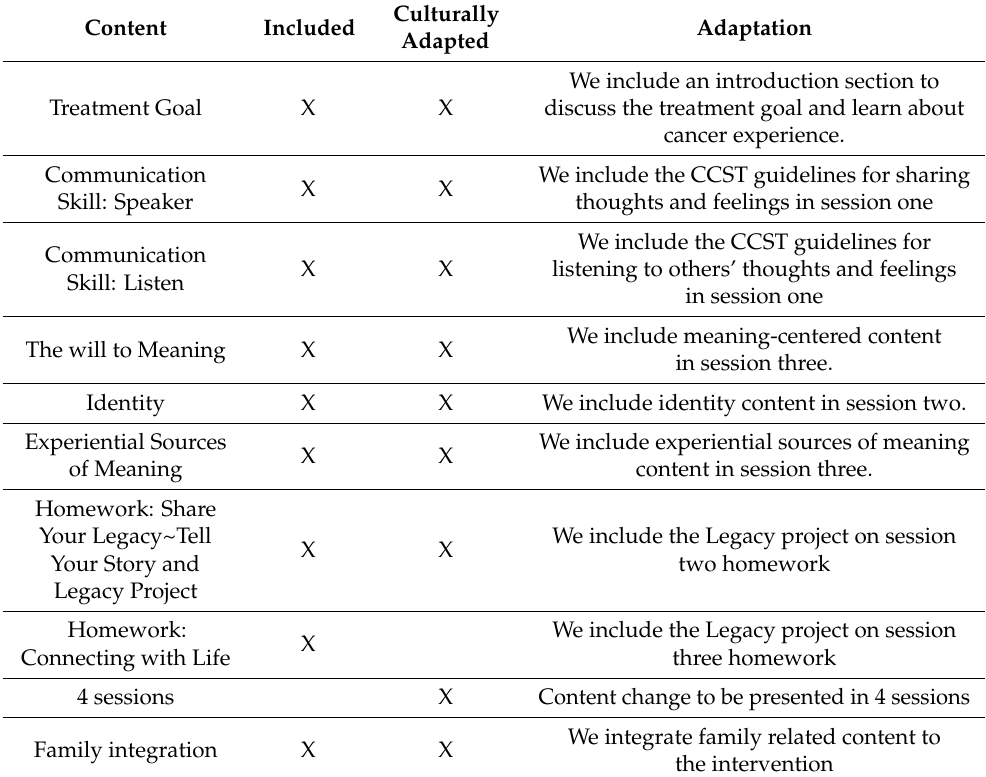
Table 5. CASA components that were culturally and linguistically adapted and integrated after the interviews and feedback. The X indicate the inclusion of intervention related content and the cultural adaptation. Included We include an introduction section to discuss the treatment goal and learn about cancer